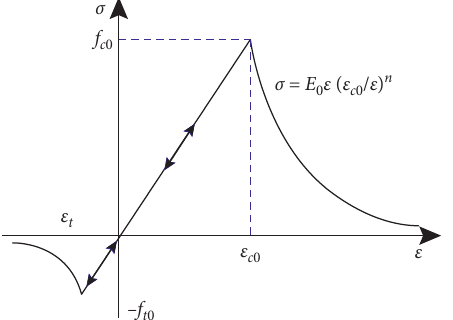
Figure 3: Constitutive model under uniaxial